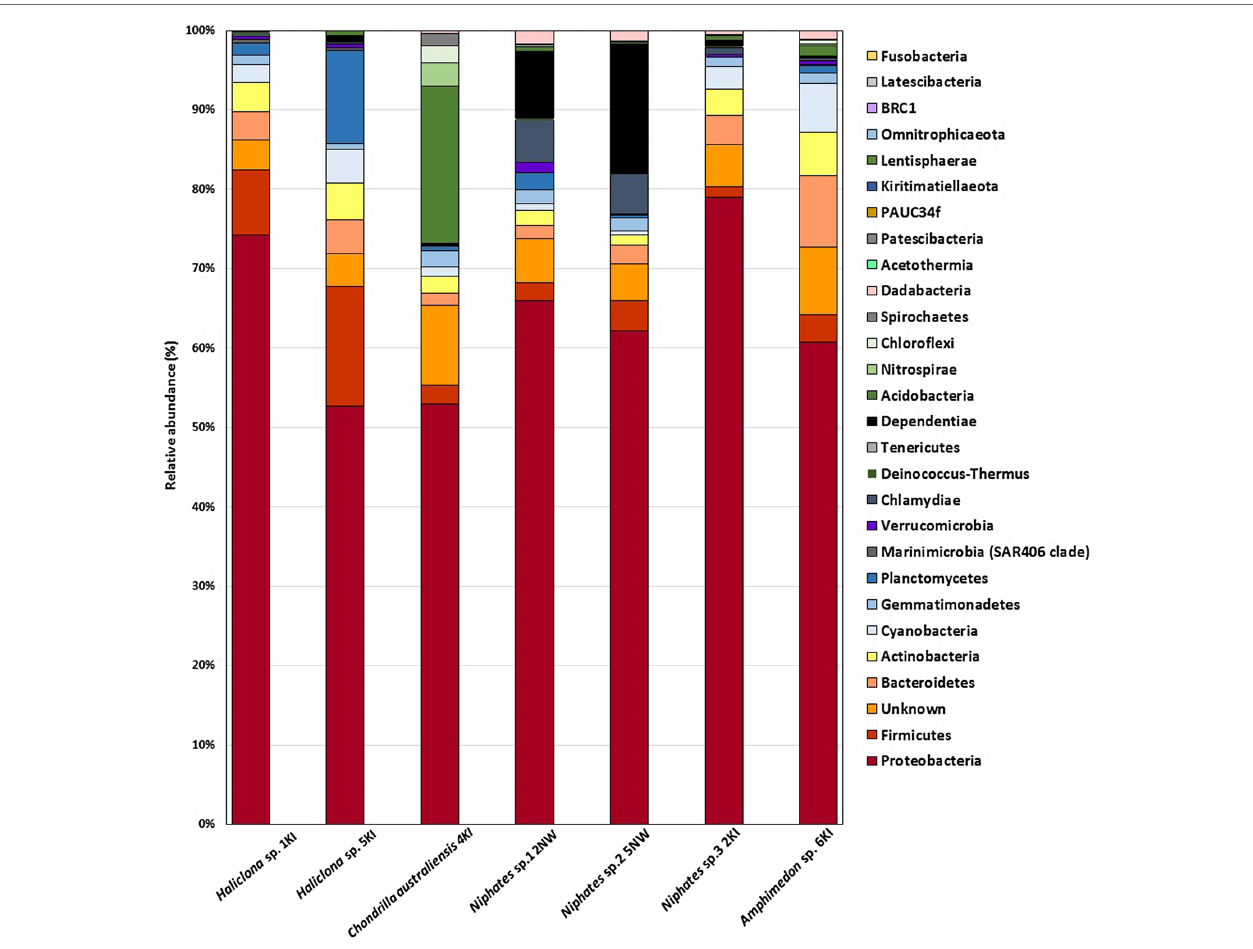
FIGURE 1 | Bar charts represent the bacterial phyla associated with sponge samples in the present